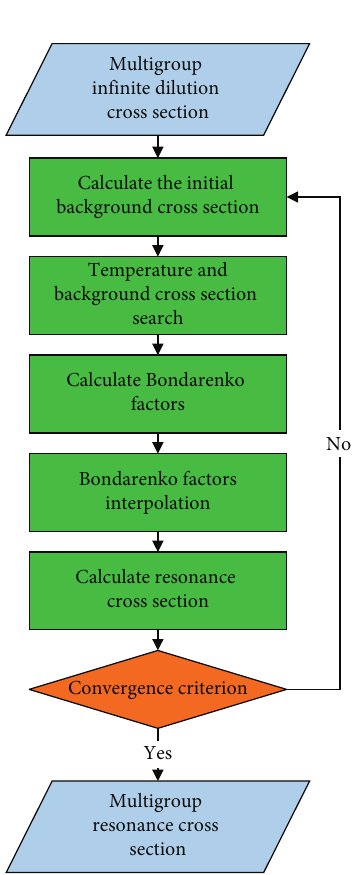
Figure 2: Processing procedure of self-shielding